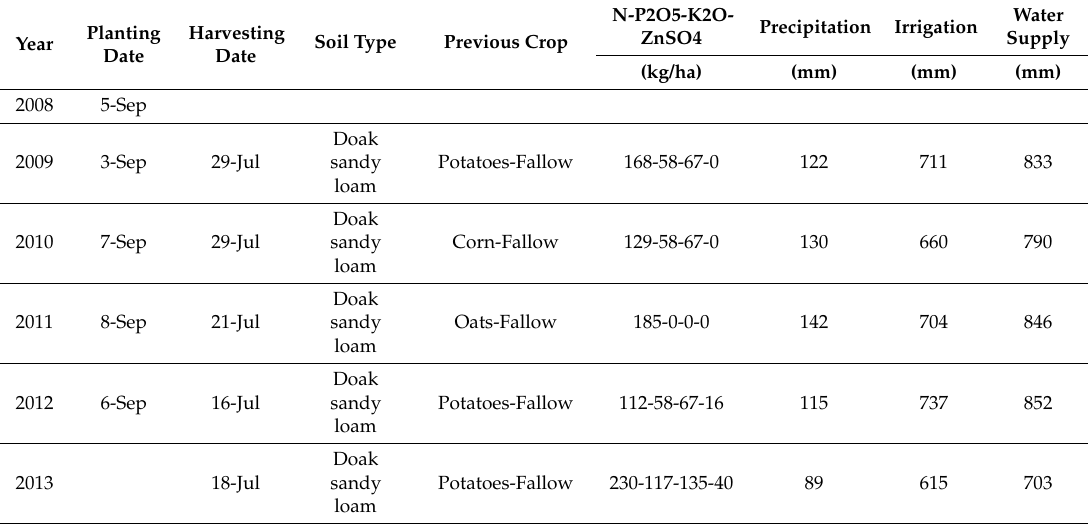
Table 1. Canola planting and harvesting date, and the applied fertilizer rate, precipitation and irrigation applied during the 2008–2013